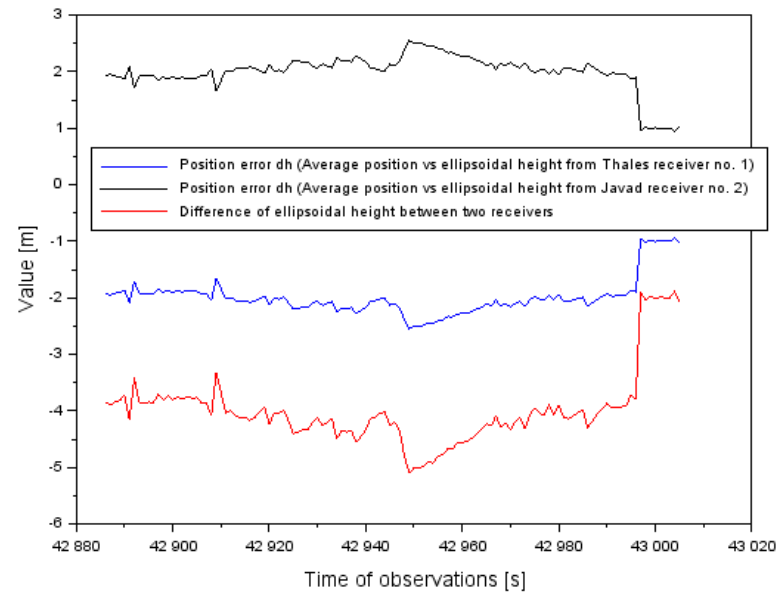
Figure 14. The position error of aircraft coordinates h in the flight test in Che ł m.